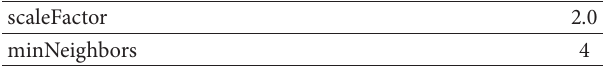
Table 3: Consumed time for each platform for Haar-like